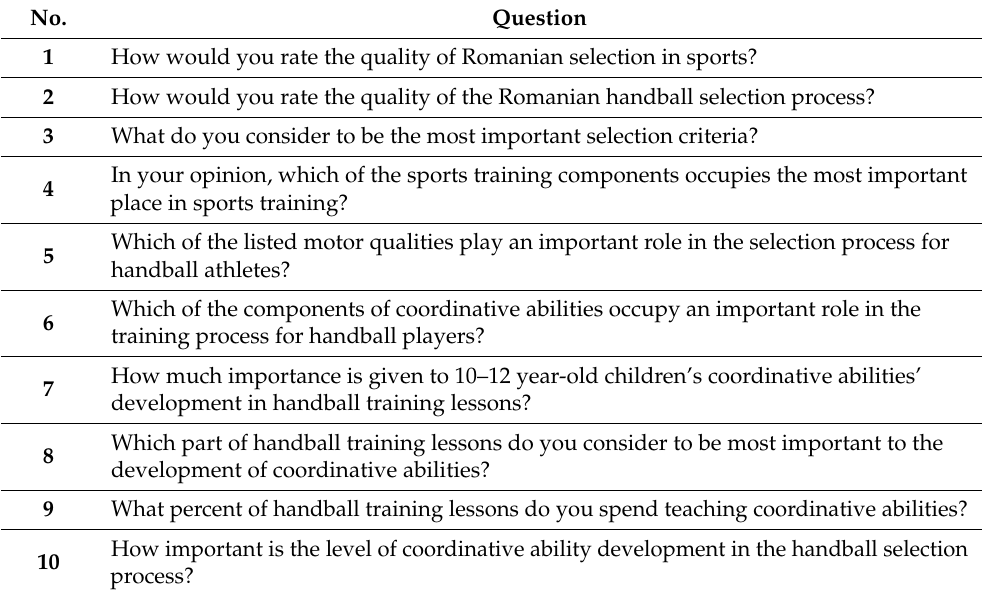
Table 1. Questions from the questionnaire proposed to evaluate the importance of coordinative abilities in the selection process for children in